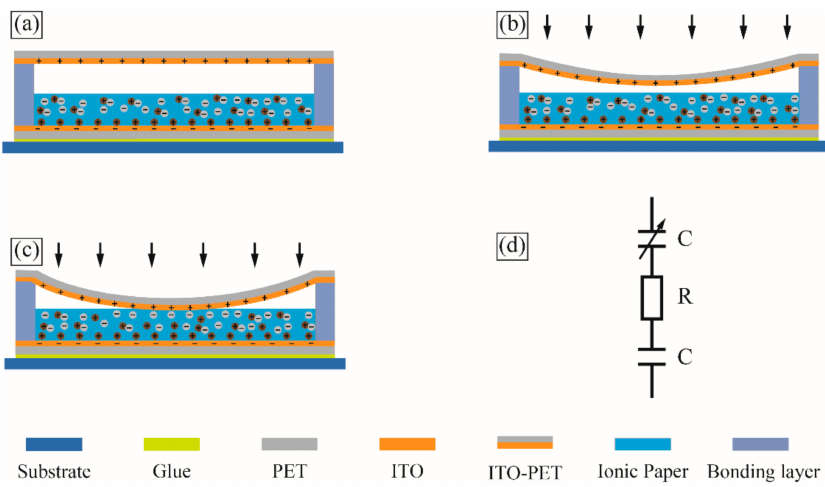
Figure 1. Sensing principle of the flexible ionic liquid super-capacitive pressure sensor. ( a ) No external pressure applied on the sensor. ( b ) Low external pressure applied on the sensor. ( c ) High external pressure applied on the sensor. ( d ) Equivalent circuit model of the